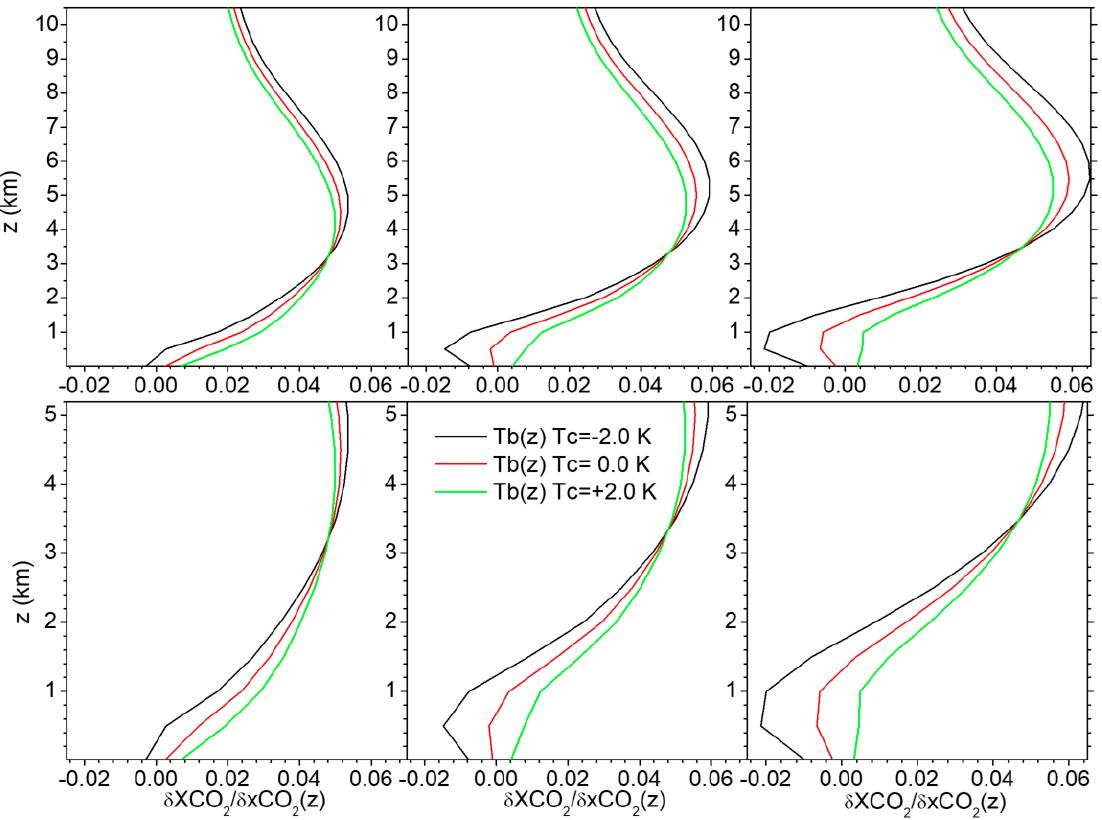
Figure 3. Representative sensitivity profiles for the three types of temperature profiles introduced above (in three panels from left to right) and for three values of the thermal contrast, i.e., TC = − 2.0 K, TC = 0.0 K, and TC = +2.0 K. A zoom has been performed (from the upper to the lower panels) to exemplify the sensibility profile in the full tropospheric profile and the sensibility profile in the lower troposphere.